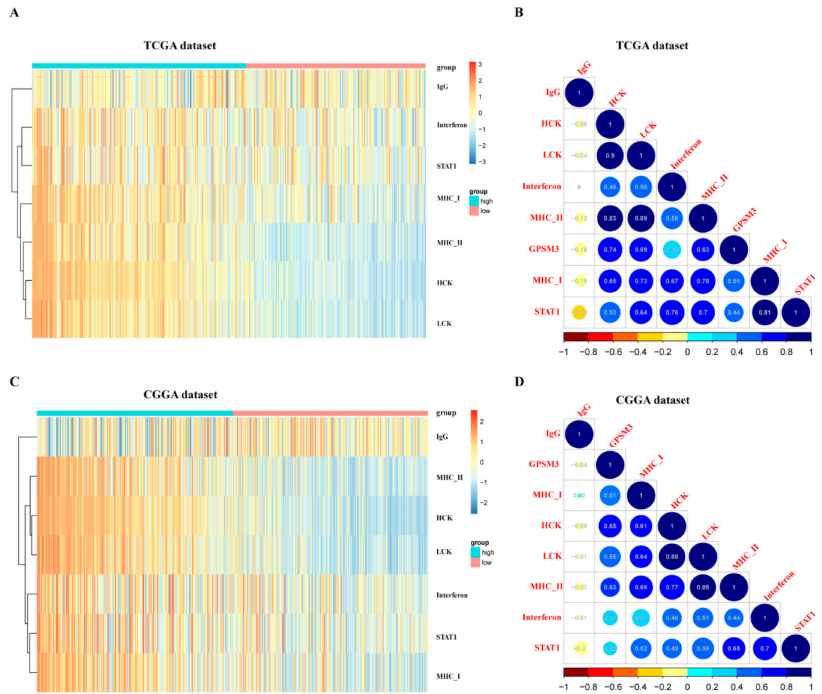
Figure 7. GPSM3-related inflammatory activities in LGG. ( A , B ) Heatmaps showing the relationship between GPSM3 and seven metagenes in TCGA and CGGA datasets. ( C , D ) Correlogram showing the correlation between GPSM3 and seven metagenes in TCGA and CGGA datasets.